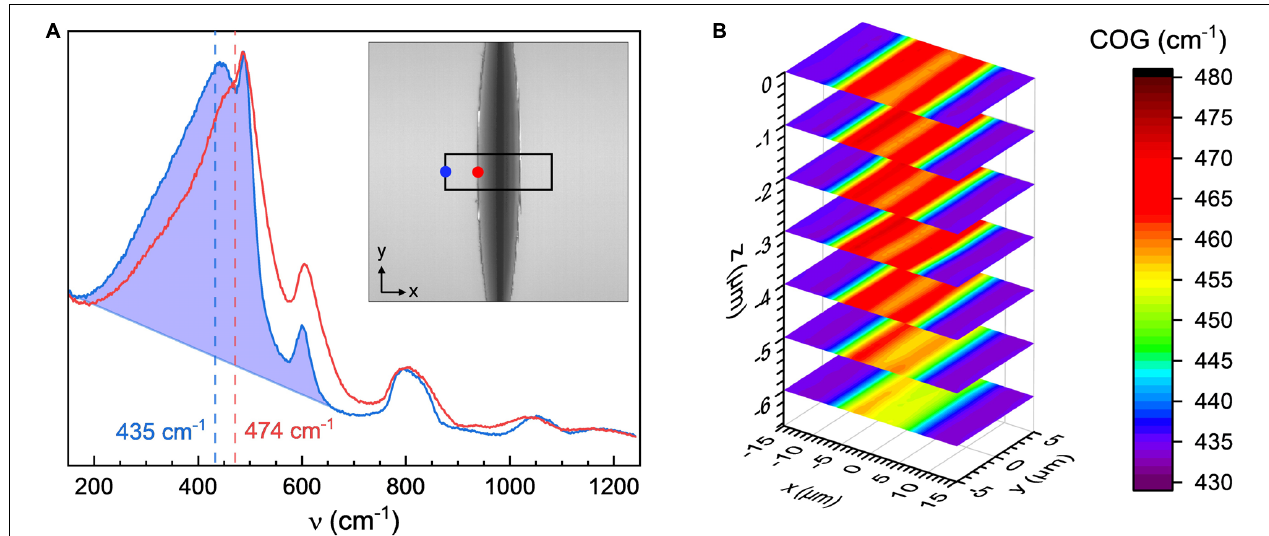
FIGURE 5 | Raman spectroscopic analysis of a residual imprint on a 440 µ m silica glass fiber, produced under a normal load of 8.98 N with a wedge with an opening angle of 90 ◦ and an effective length of 215 µ m. (A) Individual Raman spectra recorded at the rim (red curve; inset: red dot) and at a distance of 15 µ m from the center of the imprint (blue curve; inset: blue dot), respectively. The shaded section on the blue curve shows an example of the determination of the spectral center of gravity (COG); COGs are marked with dashed lines. (B) Three-dimensional representation of the COG mapped across an area of 30 µ m × 10 µ m from the fiber surface ( z = 0) and down to a depth of 6 µ